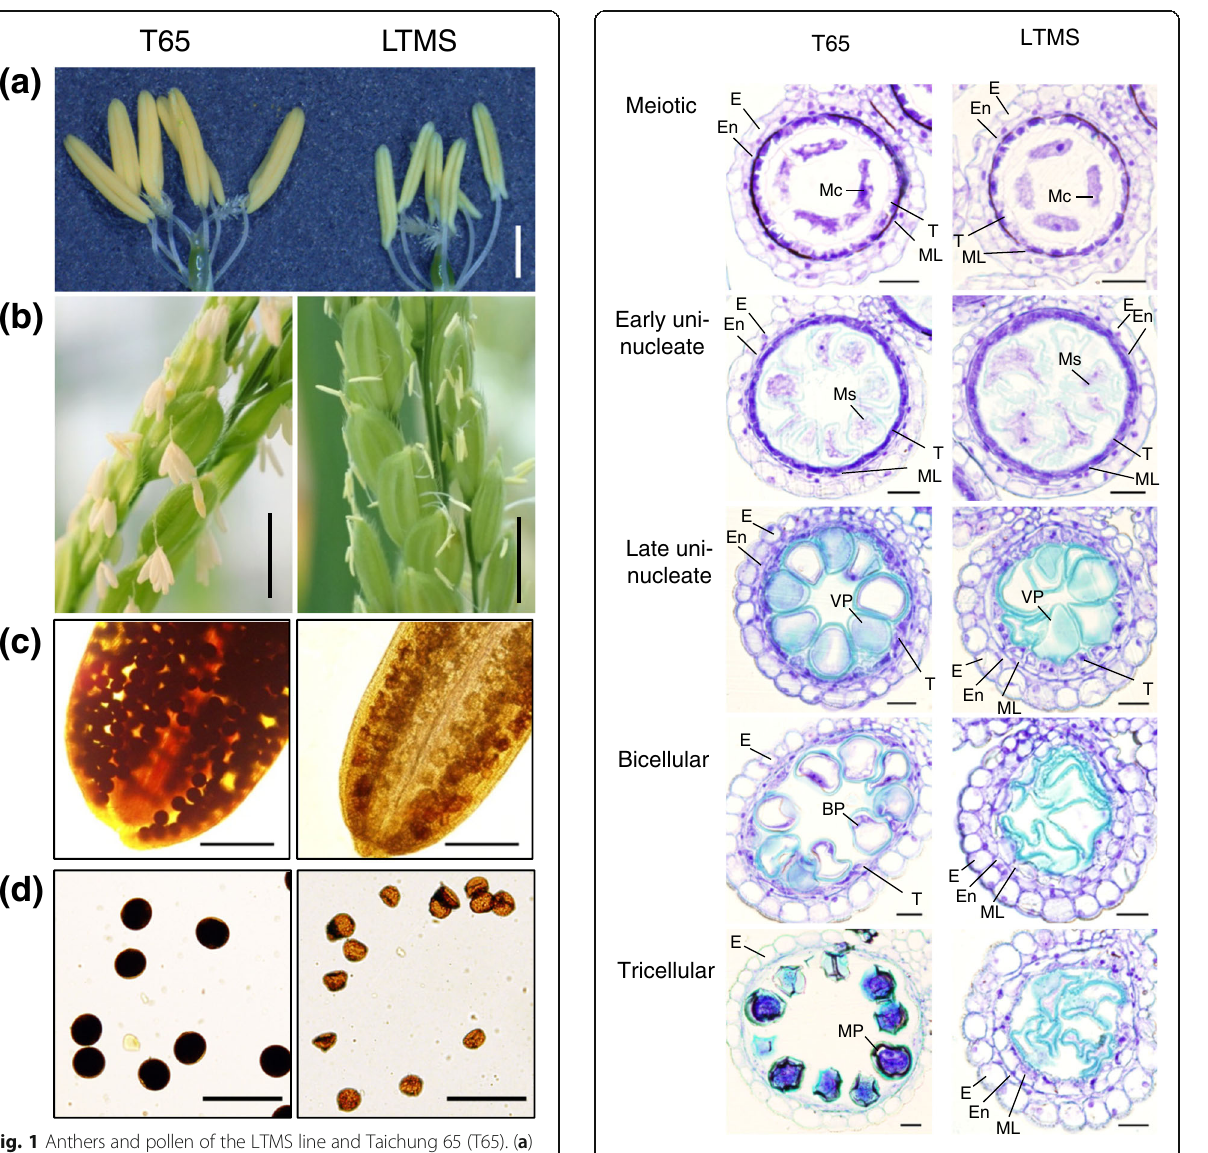
Fig. 2 Transverse section of anthers at meiotic, early and late uninucleate microspore, bicellular pollen, and tricellular pollen stages in the LTMS line and Taichung 65 (T65). BP, bicellular pollen; E, epidermis; En, endothecium; Mc, meiocyte; ML, middle layer; MP, mature pollen; Ms., microspore; T, tapetal cell; VP, vacuolated pollen. Bar = 20 μ markers (Additional file 1: Table S3). The sterile pheno- type was consistent with the presence of a heterozygous Lebed /T65 genotype at each DNA marker locus be- tween KNJ8-indel710 and SSRi98, while all the fertile plants showed T65 homozygous genotypes (Additional file 1: Table S5). These results indicate that the LTMS gene is located between KNJ8-indel702 (IRGSP-1.0 pos- ition: 11.26 Mb) and KNJ8-indel756 (IRGSP-1.0 position: 15.04 Mb), corresponding to a 3.7-Mb region in the